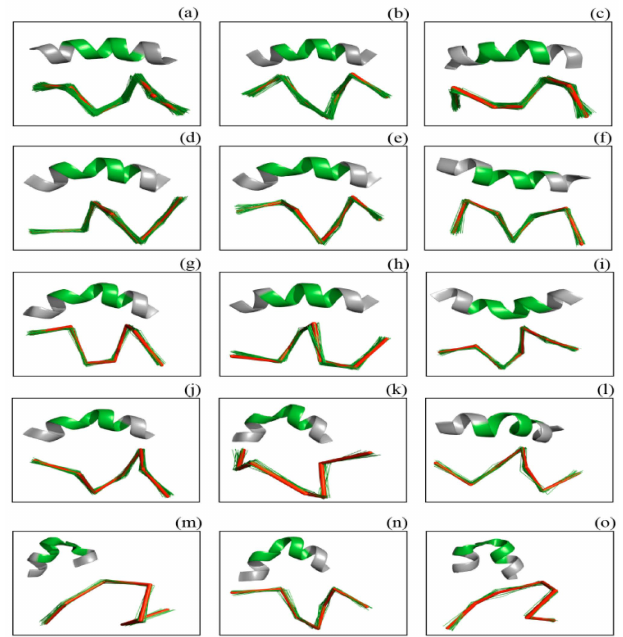
Figure 4. The clusters of α -helix bend fragments. ( a – o ) show 15 clusters after clustering α -helix bend fragments. The central fragments within clusters are displayed as red stick and green cartoon models, and the other fragments within clusters are displayed as green lines. We only show the odd clusters after the clusters were ordered by the number of fragments because this figure is an intuitive illustration of our